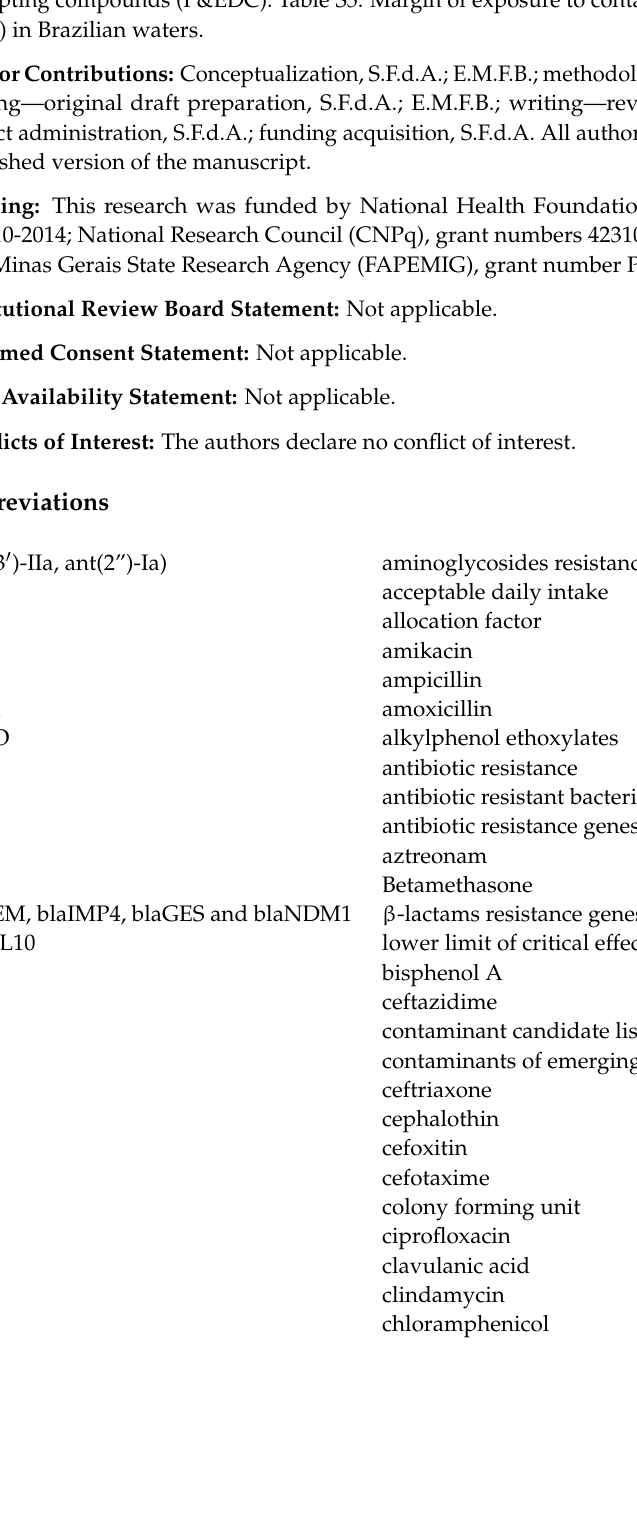
active ingredient or association of active ingredients. Table S2: Occurrence of Pharmaceuticals and Endocrine Disrupting Compounds (P&EDC) in Brazilian waters (raw data). Table S3: Occurrence of Pharmaceuticals and Endocrine Disrupting Compounds (P&EDC) in foreign waters (raw data). Table S4: Toxicological studies and guideline values (GV) for selected pharmaceutical and endocrine disrupting compounds (P&EDC). Table S5: Margin of exposure to contaminants of emerging concern (CEC) in Brazilian